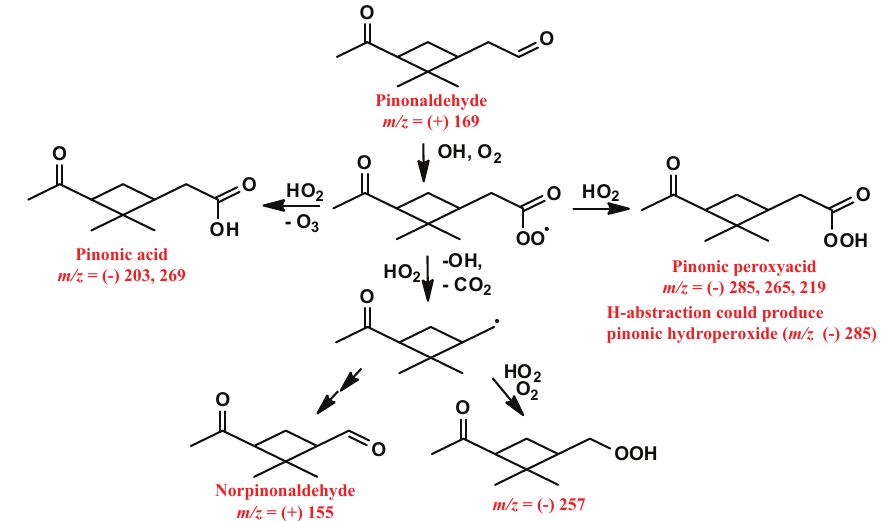
Fig. 2. Pathway of photooxidation of pinonaldehyde under low-NO x conditions. Species that were observed are labeled in red. Pinonic acid and pinonic peracid were observed in the negative mode as both the transfer ion (molecular mass+19) and the complex (molecular mass +85), pinonic peracid is also observed as the complex minus HF (molecular mass +65), norpinonaldehyde hydroperoxide was observed as the complex ion, pinonaldehyde and norpinonaldehyde are observed in the positive mode at their molecular mass +1.